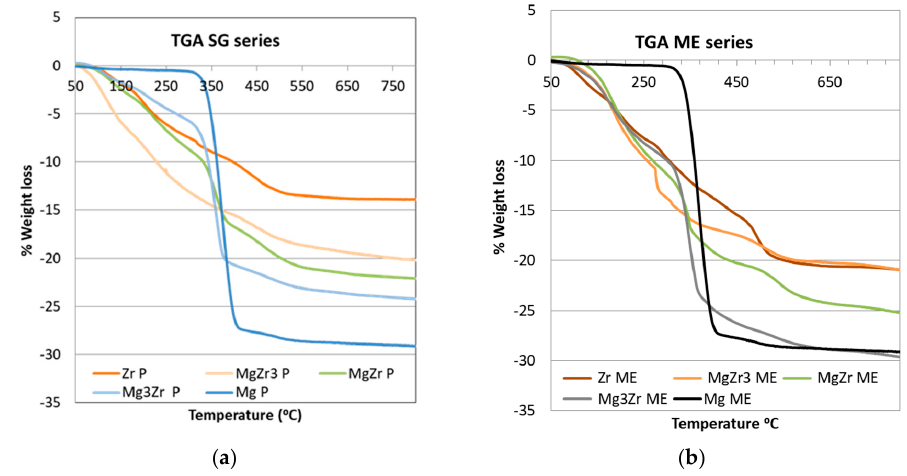
Figure 1. Thermogravimetric analysis (TGA) of the dried gels corresponding to both series of solids synthesized: ( a ) Sol-Gel and ( b ) Microemulsion.